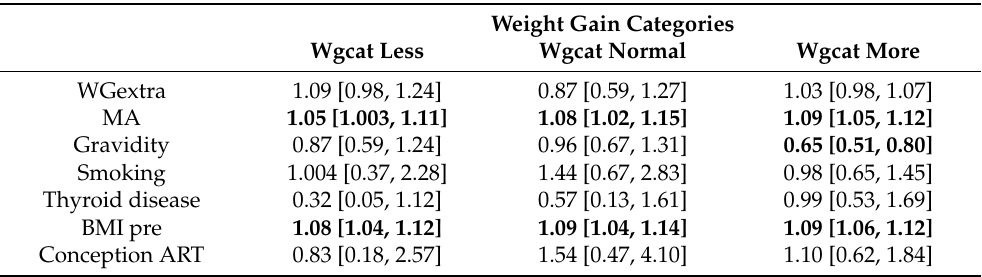
Table 5. Subgroup analyses for the different weight gain categories (less, normal, more) adjusted to MA, gravidity, smoking, thyroid disease, BMI pre, and ART. Weight Gain Categories Wgcat Less Wgcat Normal Wgcat More WGextra 1.09 [0.98,